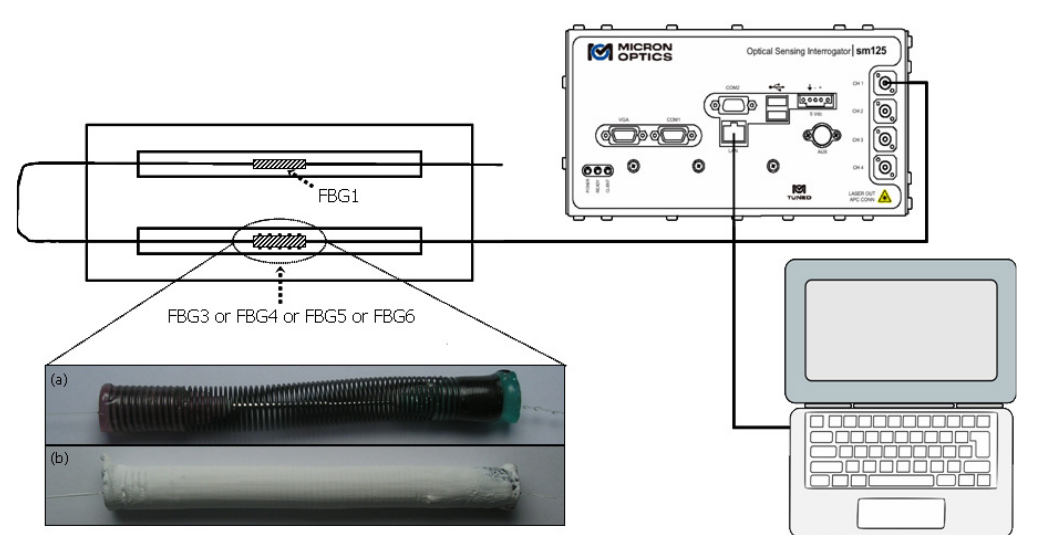
Figure 3. Schematic of experimental set-up used to monitor the paint stress kinetics during its